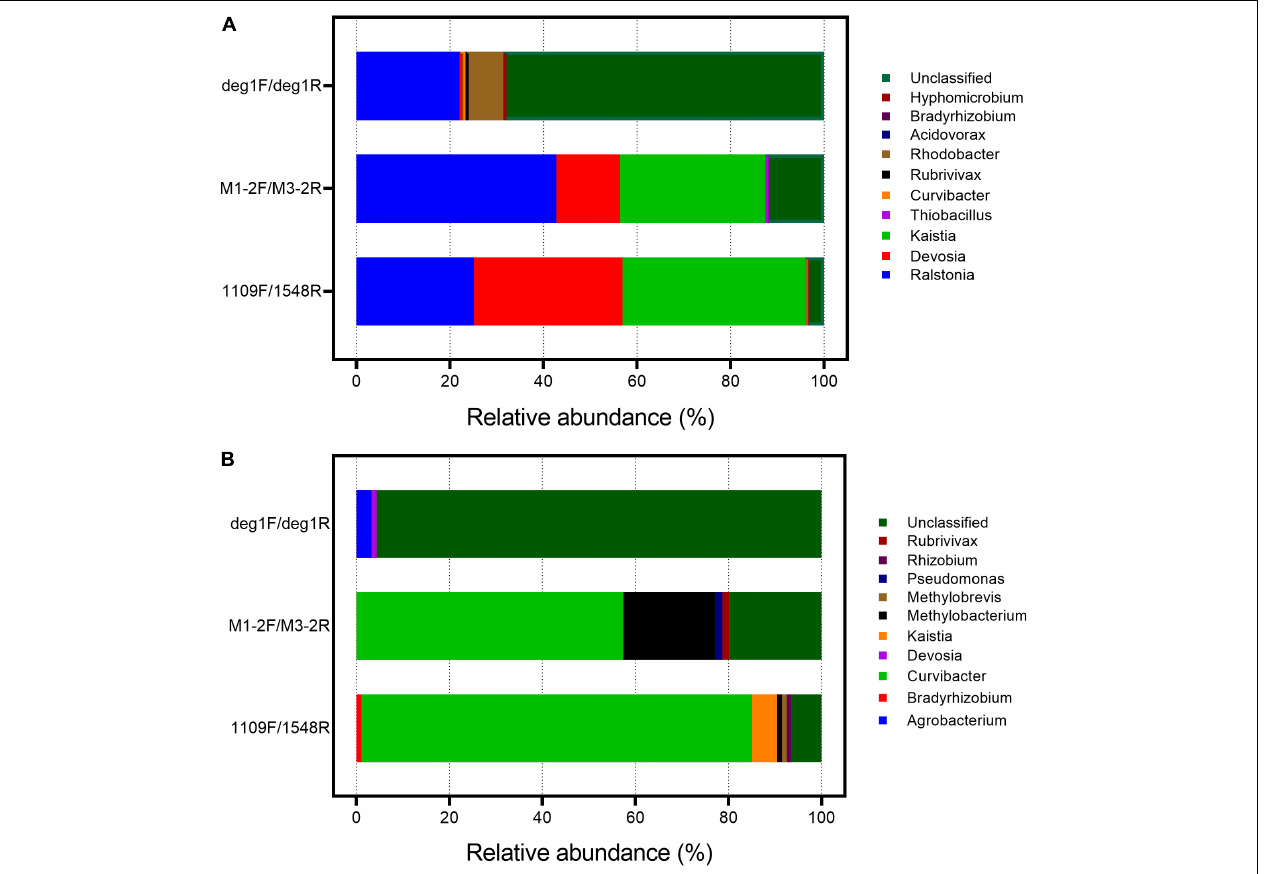
FIGURE 1 | Taxonomic information of the clone sequences generated using three primer pairs and DNA from the As-contaminated paddy soil (A) and sediment (B) . The aioA -targeted clone sequences were verified using the BLASTX similarity search against the NCBI-nr database at e < e - 10 and alignment length > 150 nt. Specificities of the primer sets were calculated as the aioA -target sequence hits to the total number of clone sequences. The taxonomic information for the aioA clone sequences is shown at the genus level after disarming non- aioA sequences.